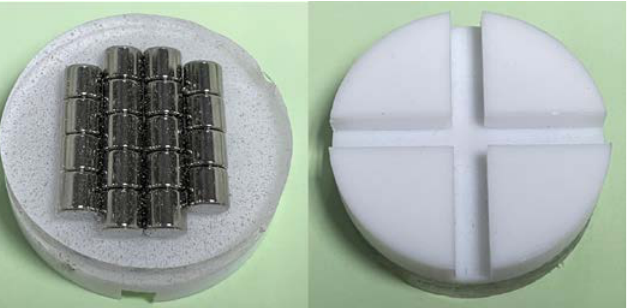
Figure 1. Photographs of a home-made Teflon magnetic rotary disk, back side and front side, sepa- rately.